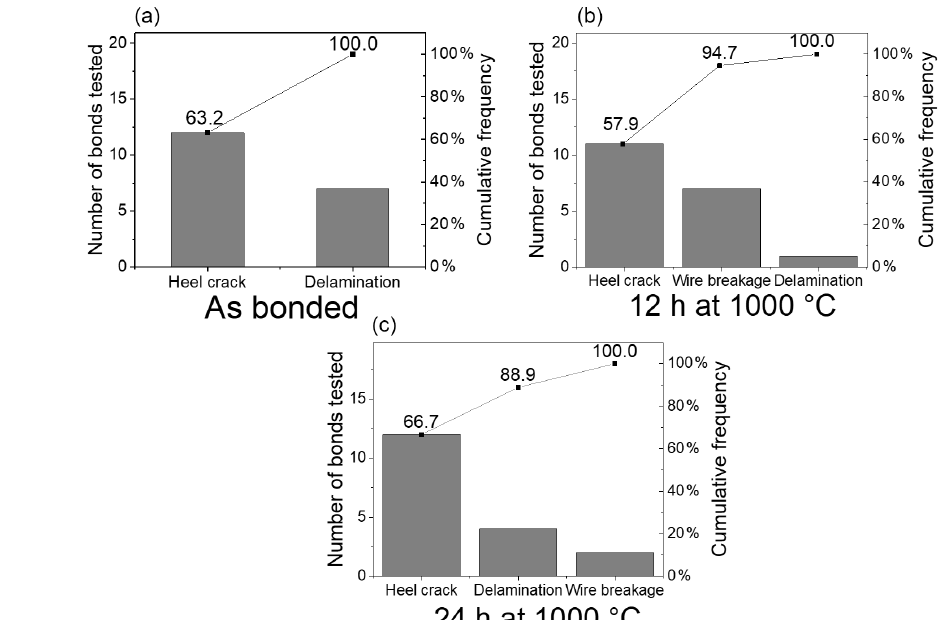
Figure 12. Frequency of the failure mechanisms of wire bonds, for different ageing conditions, bonded to thick film. (a) No annealing, (b) aged for 12h at 1000 ◦ C, and (c) aged for 24h at 1000 ◦ C.